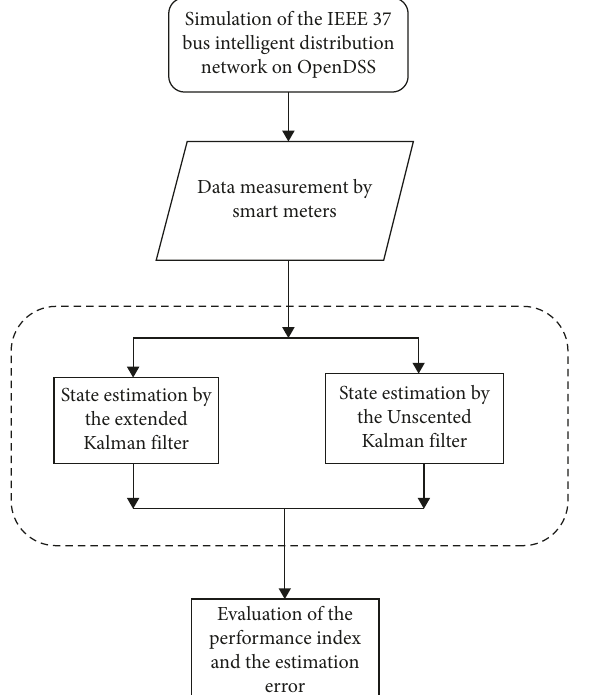
Figure 3: Proposed flowchart for the hybrid state estimation algorithm.